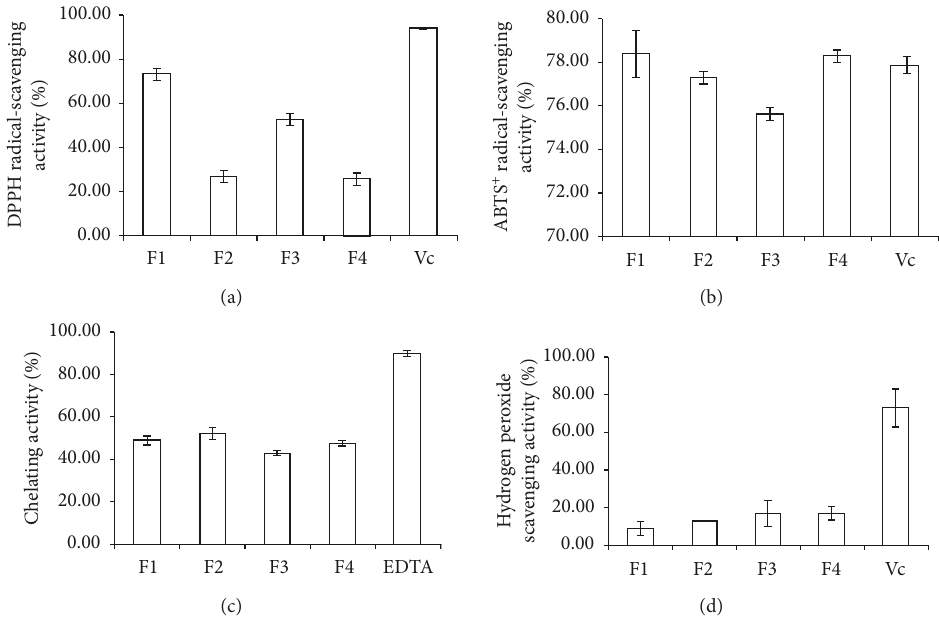
Figure 4: The DRSA of the eluted peaks from Sephadex G-25 column. All the results are triplicates of mean ±